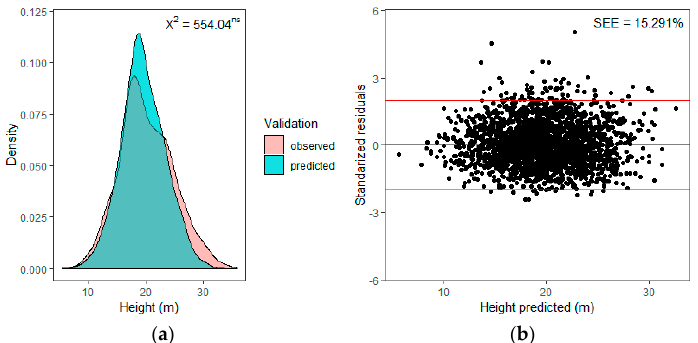
Figure 8. Density histogram ( a ) and standardized residuals ( b ) in the validation. X 2 : chi-square test; ns : not significant with 95% probability level; SEE%: standard error of estimate in percent.